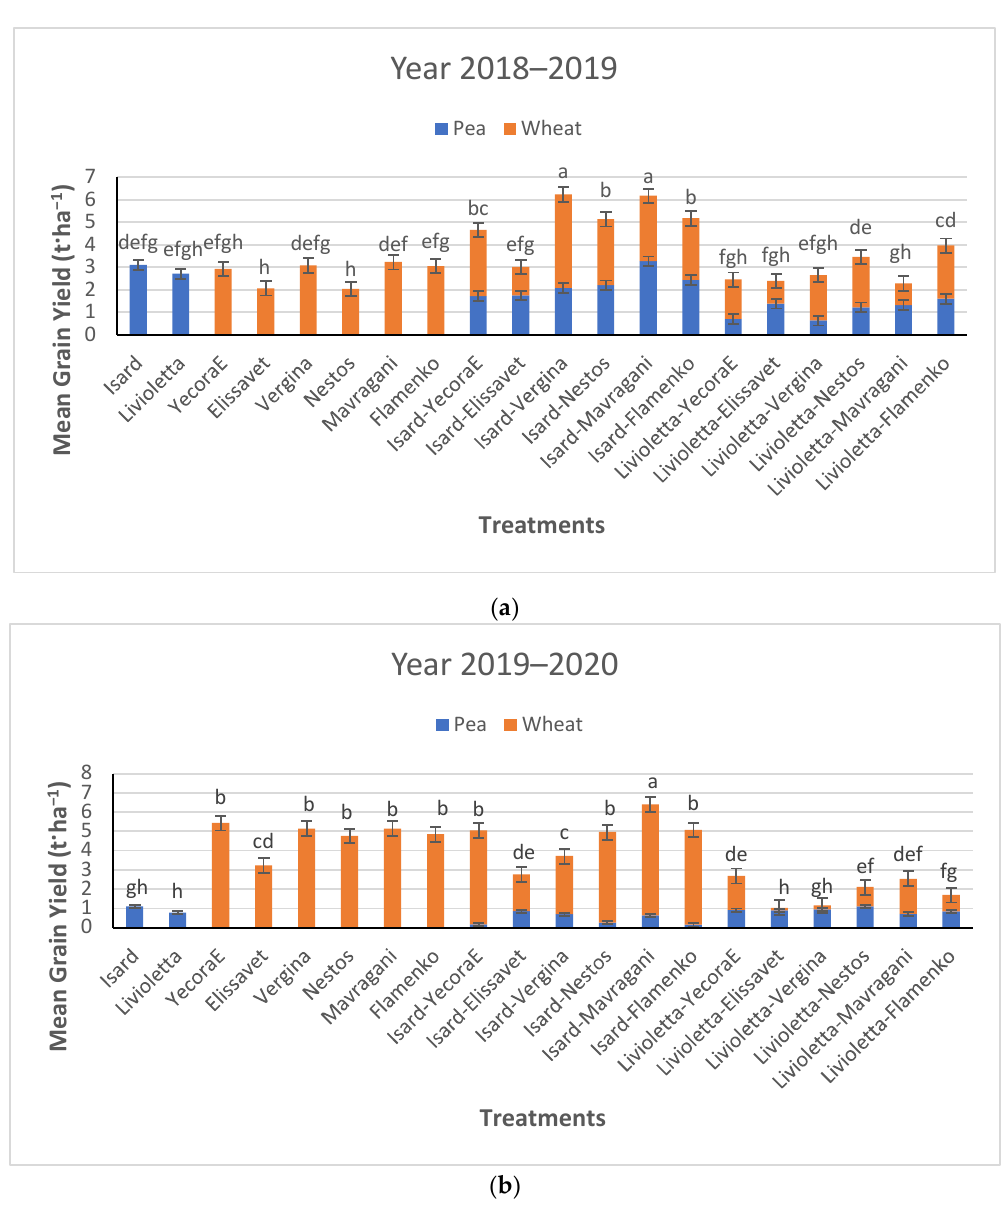
Figure 2. Grain yield of monocultures and intercrops in the two growing seasons: ( a ) 2018–2019; ( b ) 2019–2020 (LSD 0.05 = 1.27). Means followed by the same letter are not statistically significantly different, at significance level of 0.05, according to the LSD criterion.